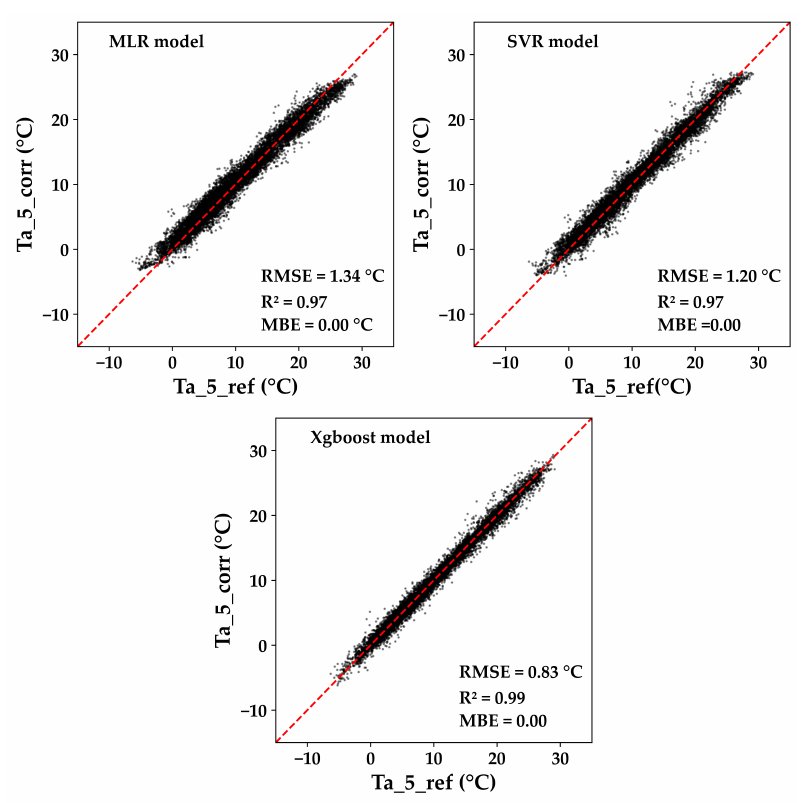
Figure 8. Comparison of Machine Learning predictions for Ta_5_ref